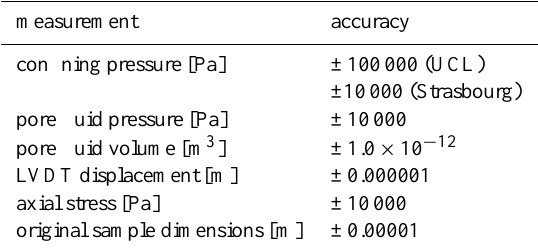
Table 2. Summary of the estimated measurement accuracy. Table 3. Expected natural variability between tuff samples cored